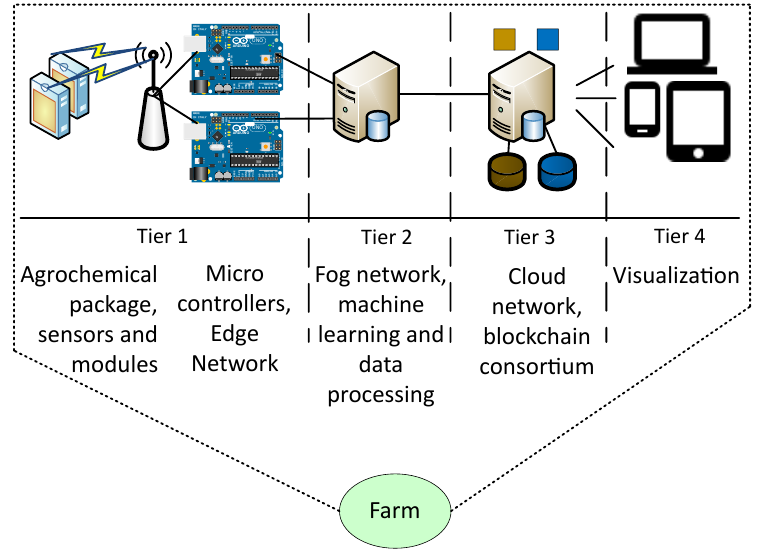
Figure 5. Detailing the tier composition inside a particular